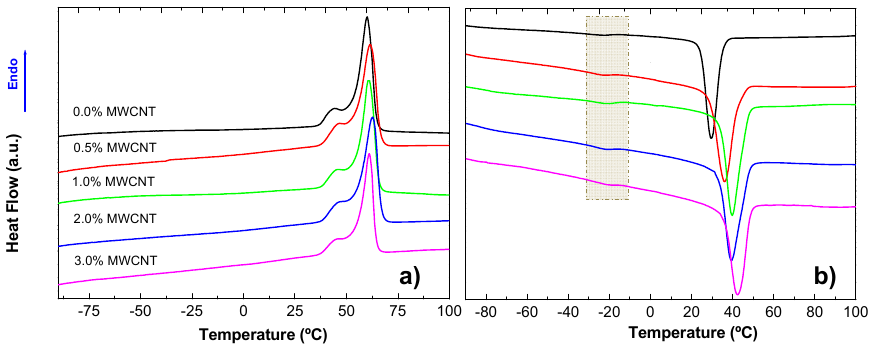
Figure 7. Thermograms corresponding to the ( a ) first heating and ( b ) subsequent cooling DSC scans.